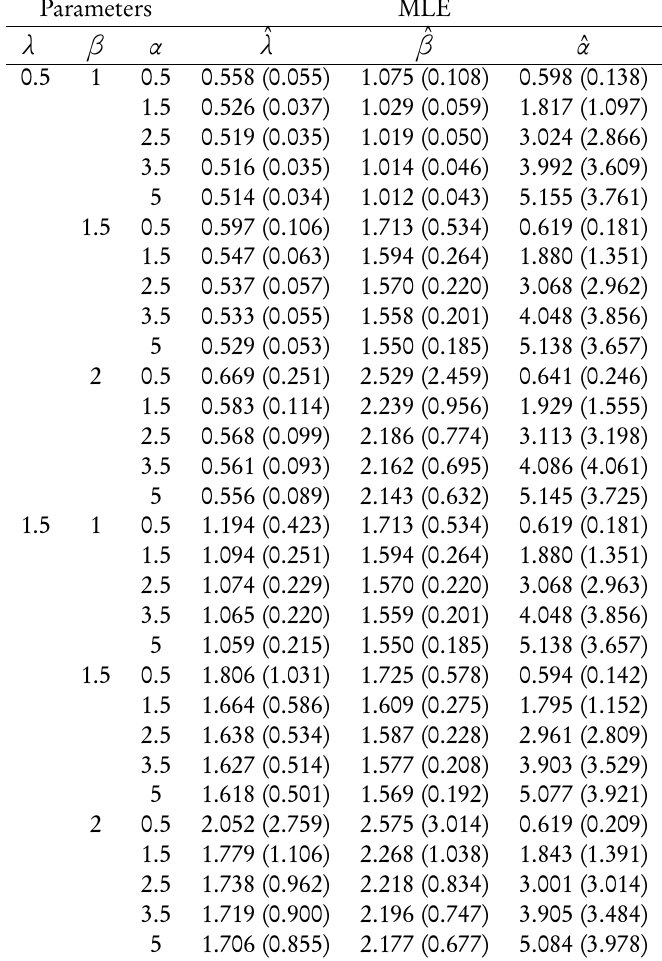
Average value of the estimates of the parameters and the corresponding MSEs (in parentheses) for n = 50